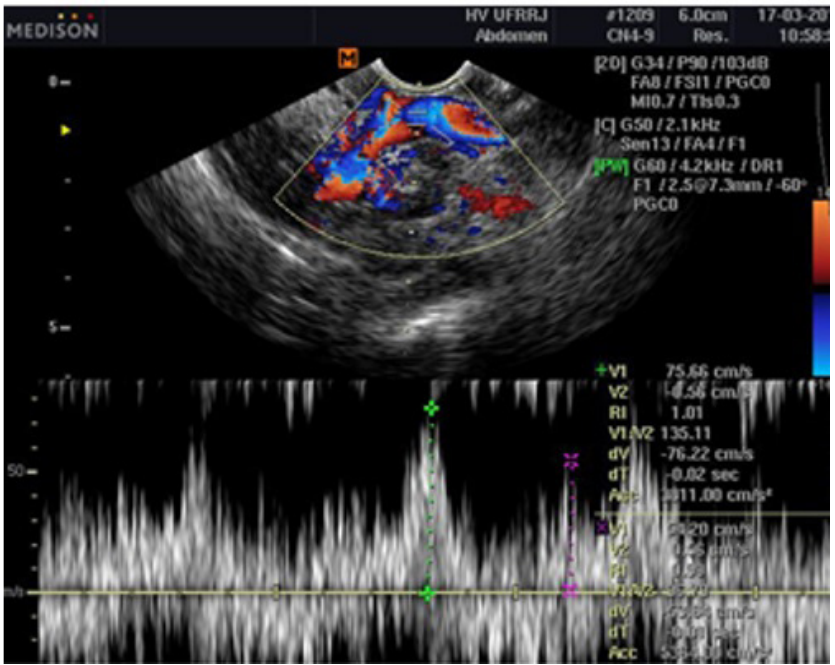
Figura 2. Imagem ultrassonográfica com Doppler colorido direcional e onda espectral da anomalia vascular do